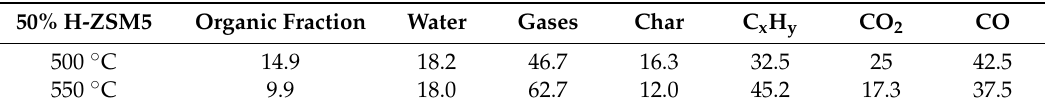
Table 4. Effect of the pyrolysis reaction temperature on different pyrolysis products yields and gas composition.